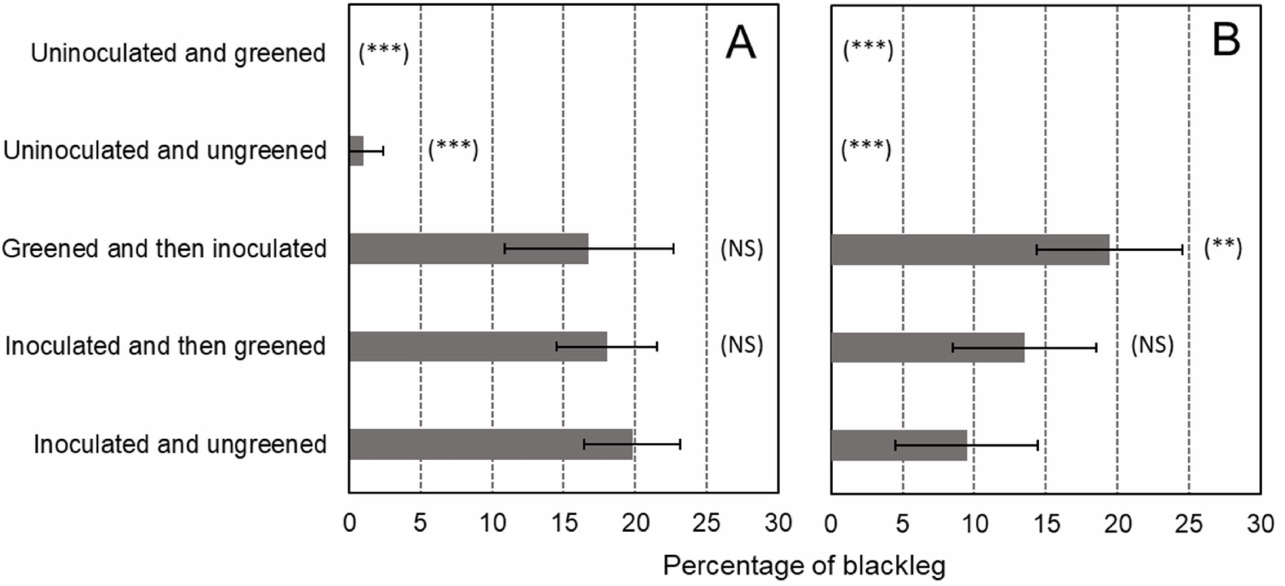
Figure 3. Percentage of blackleg in the trials of 2019 ( A ) and 2020 ( B ). The results of the mean comparison Dunnett test are presented in brackets: (NS) for “non-significant”; (**) for p < 0.01; (***) p < 0.001. Each treatment is compared with the inoculated and ungreened treatments. The error bars represent the standard